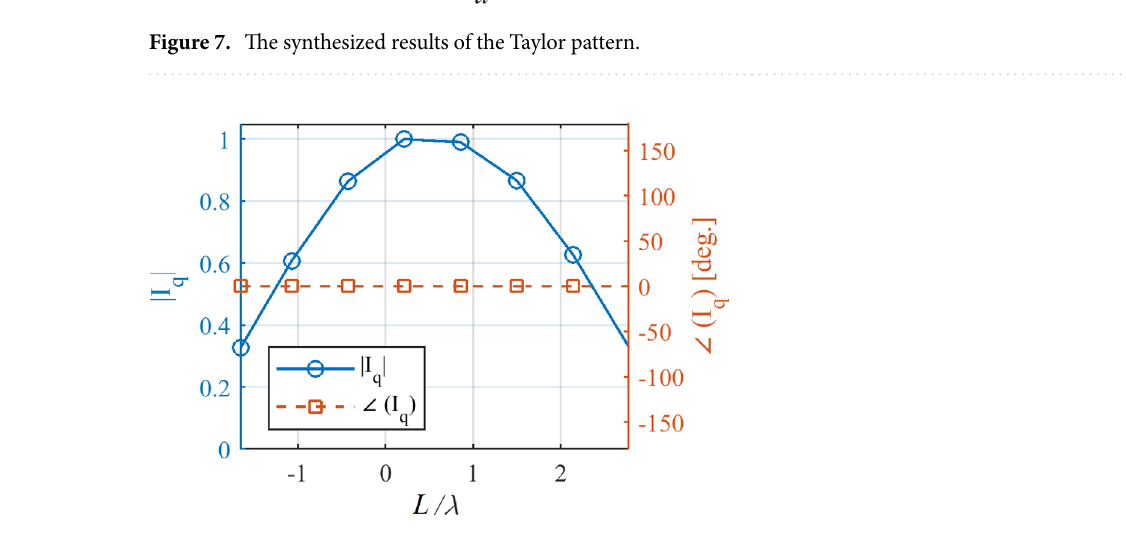
Figure 8. The calculated In versus L/λ for the Taylor